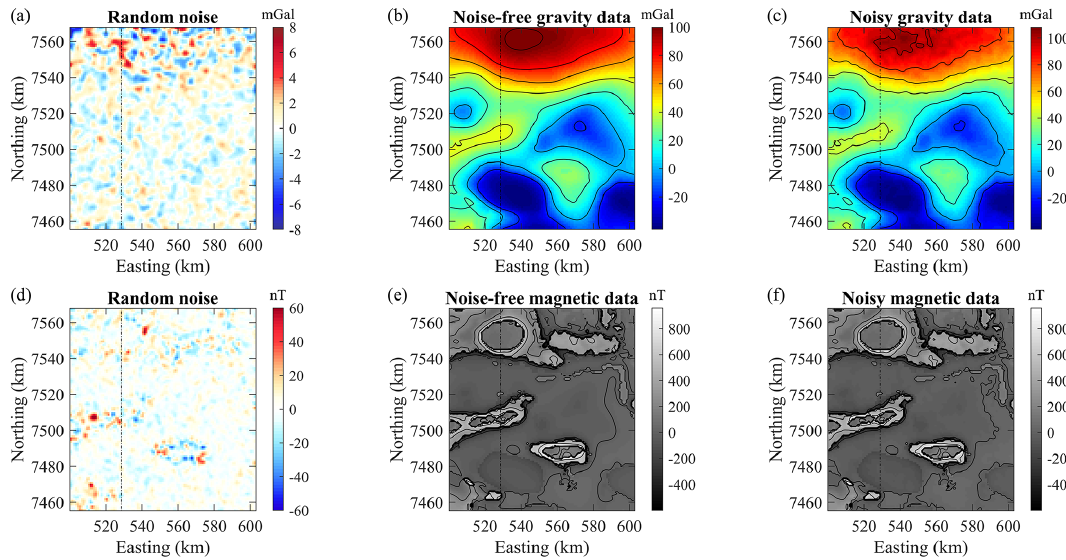
Figure 4. Noise (a, d) added to the data calculated from the true model (b, e) and resulting noisy data (c, f) for the gravity (a–c) and magnetic (d–f) data sets. The contour lines shown correspond to the ticks shown in the palette’s colour bar. The black line represents the location profile we use for the inversions performed here.